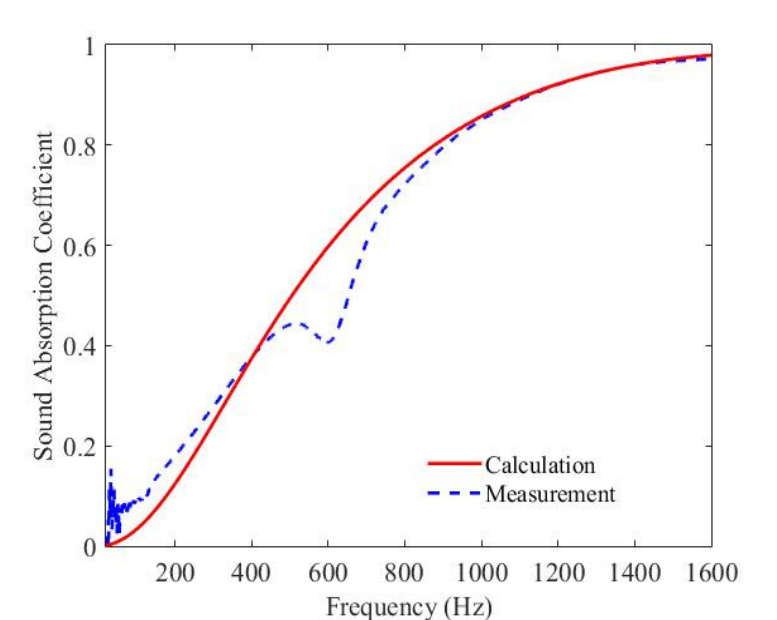
Figure 5. Sound absorption coefficient of the melamine foam. The red solid line and blue dashed line represent the calculated results by inversion method and directly measured results, respectively.